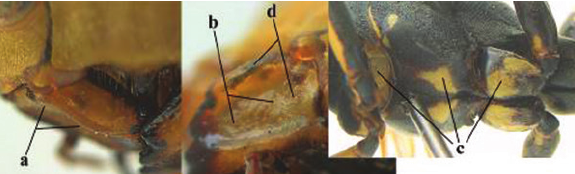
Basal half of mandible sinuate in dorsal view (a); mandibular depression strongly concave (b); [mandible mainly yellow or brown (d); fore and middle coxae and mesopleuron ventrally usually with yellow pattern (c); dorsal ridge of mandible at most 0.25 times mandibular width and prominent]; SE and southern C Europe to Central Asia ................. P. semenowi Morawitz, 1889